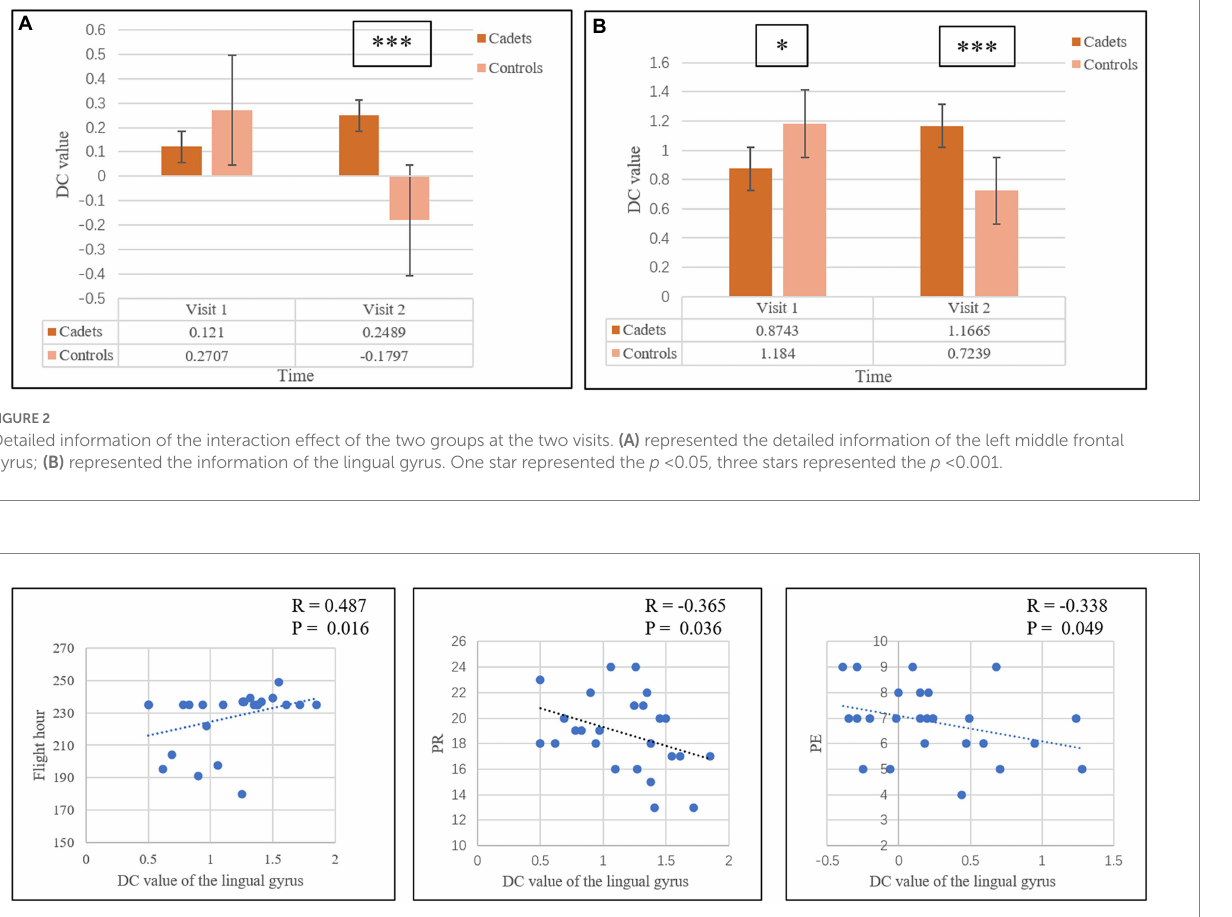
FIGURE 3 The significant relationship between the brain functional properties and behavioral indices in cadets ( p < 0.05).